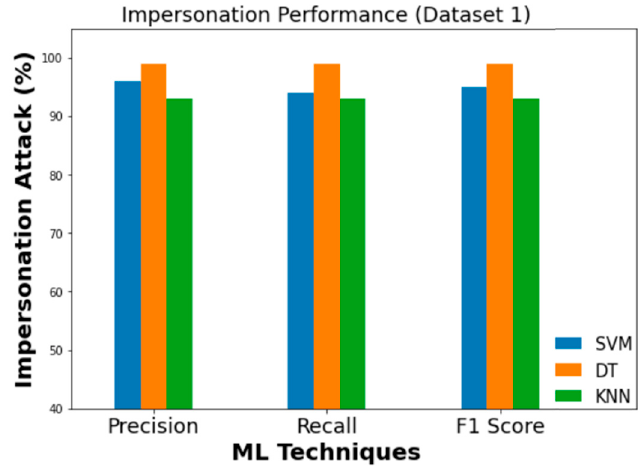
Figure 17. Performance evaluation metrics (fuzzy).